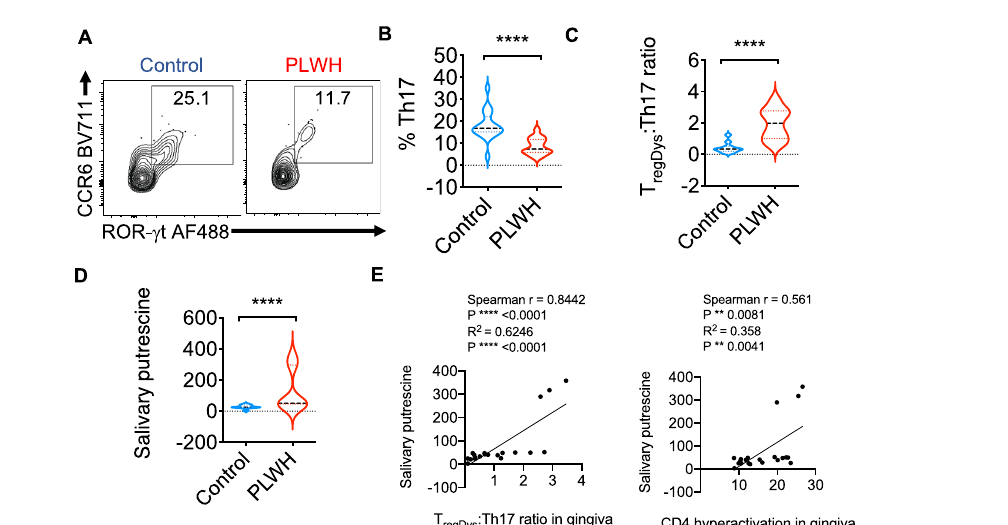
Fig. 9 | HIV+ patients have skewed T regDys /Th17 ratios and CD4 + T cell hyper- activation correlating with salivary putrescine in the oral mucosa. Gingival mucosal cellsfrom healthy controls( n =19) and PLWH ( n =30) were processedfor fl owcytometryexvivo. A , B Th17cellswerequanti fi edbyexaminingtheexpression of ROR- γ t and CCR6 in CD4 + T cells. Contour plot( A ),and statistical quanti fi cation ( B ), show Th17 proportions. The increase in T regDys proportions and Th hyper- activation (CD38 + HLADR + CD4 + T cells) in this PLWH cohort were previously published 4 . C Statisticalquanti fi cationofT regDys /Th17ratiosasdeterminedby fl ow